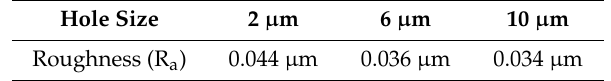
Table 1. Surface roughness of Mf-MLAs with each type of microlens (cuto ff : 8 µ